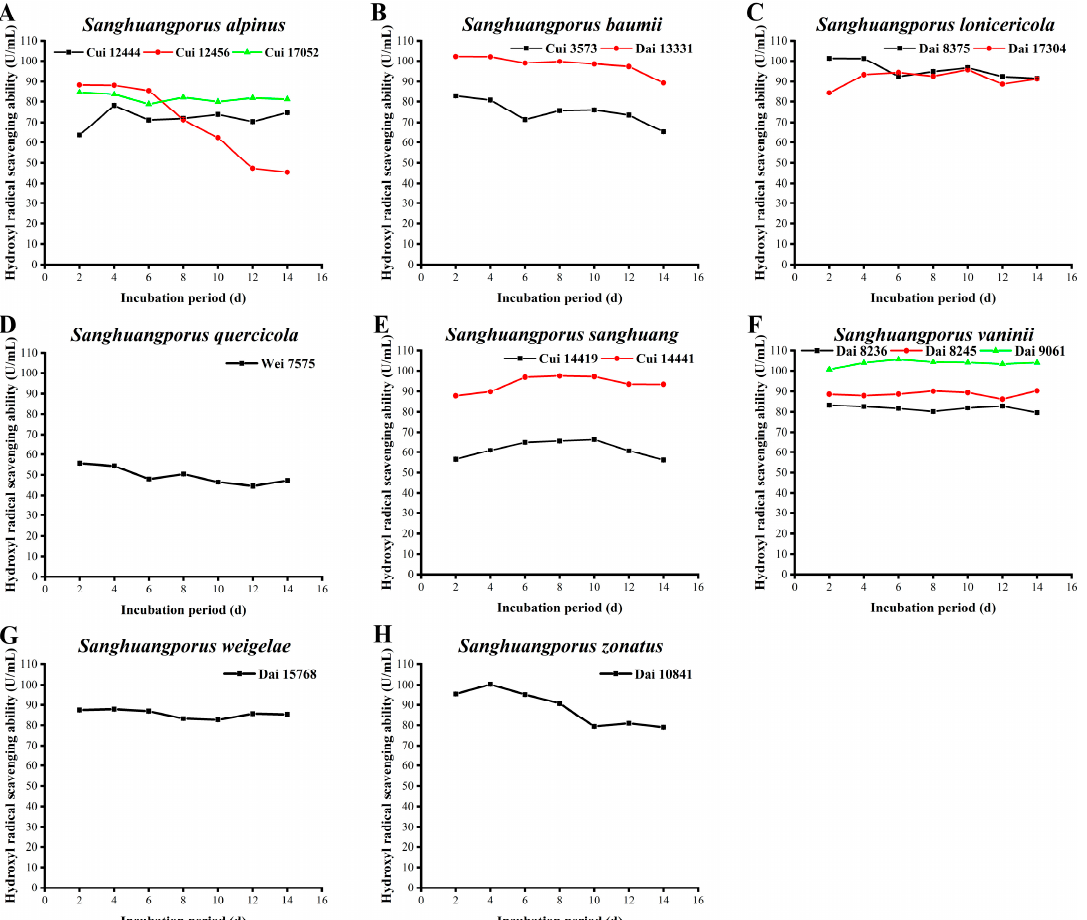
Figure 7. Variations in hydroxyl radical scavenging activities during submerged fermentation of 15 wild strains from 8 species of Sanghuangporus . ( A ) Sanghuangporus alpinus Cui 12444, Cui 12456,